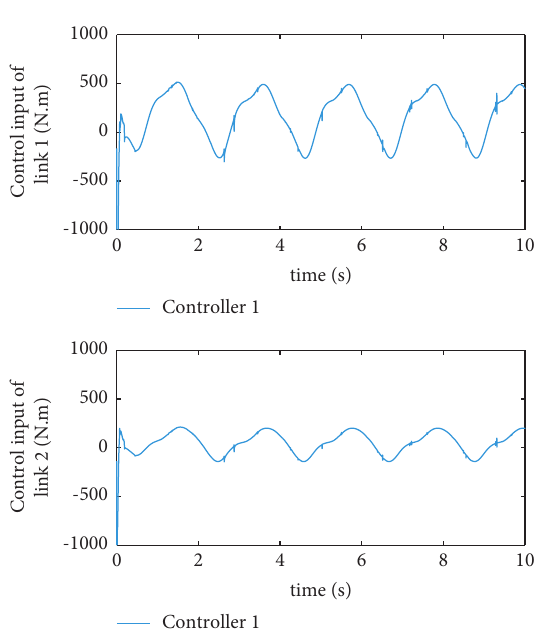
Figure 9: Control